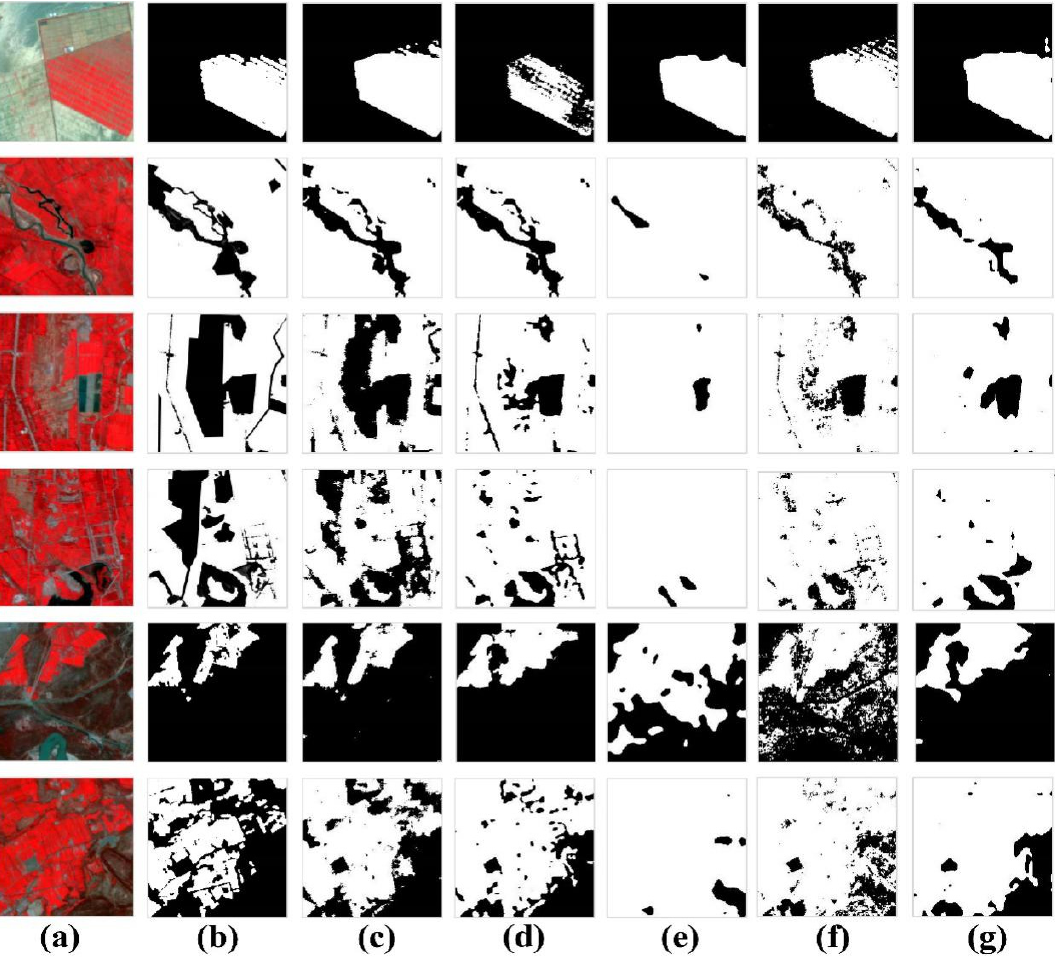
Figure 6. Cotton identification results from six subimages by different models; ( a ) the false color composite subimages, ( b ) the cotton ground truth, and the cotton identification results by ( c ) the DenseNet, ( d ) the ResNet, ( e ) the VGG, ( f ) the SegNet and ( g ) the DeepLab v3+ respectively. The white color indicates the identified cotton fields.